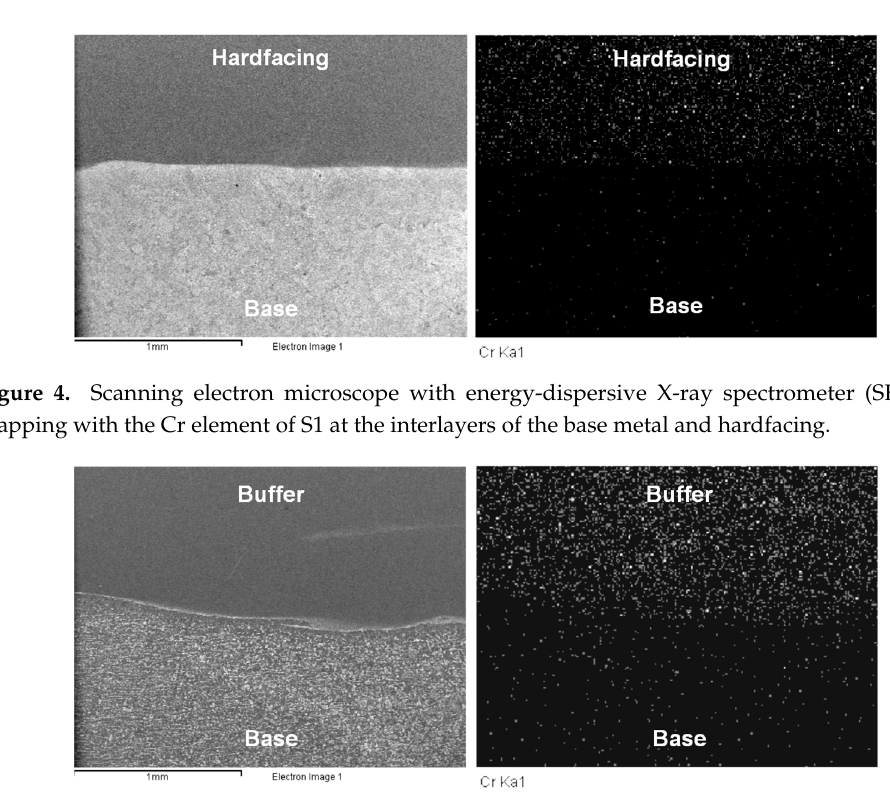
Figure 5. SEM-EDS mapping with Cr element of H2 at the interlayers of the base metal and buffer.